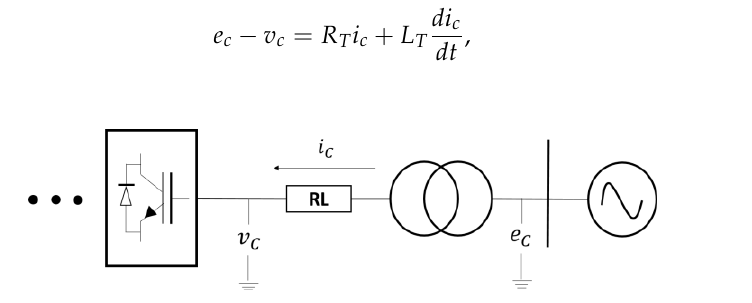
Figure 1. Voltage Source Converter single diagram.